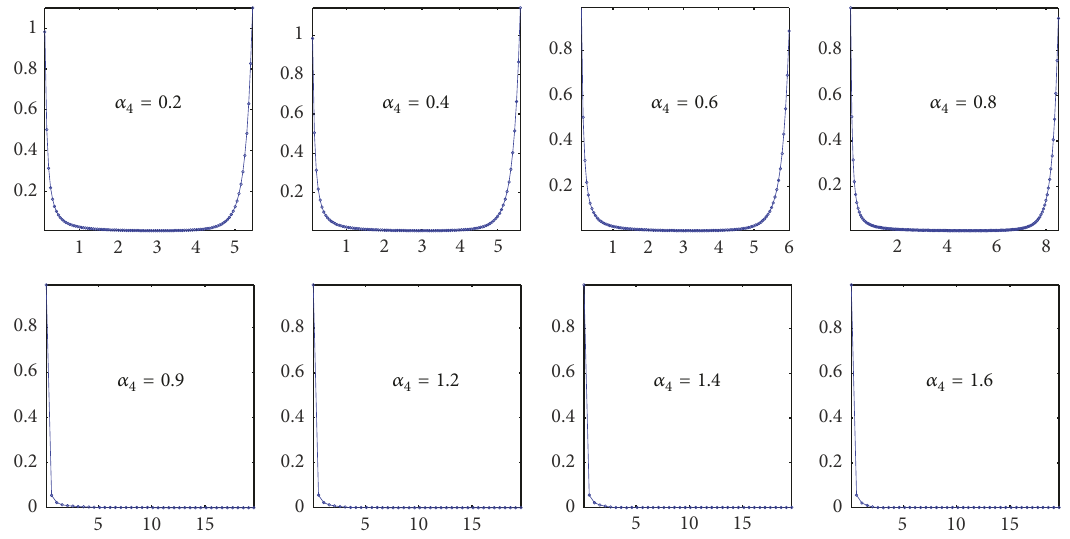
Figure 5: Variation of energy density against time for 𝛼 1 = 0.5 , 𝛼 2 = 0.5 , 𝜔 = 1 , 𝜙 0 = 1 , 𝑐 2 = 0.1 , and different 𝛼 4 .